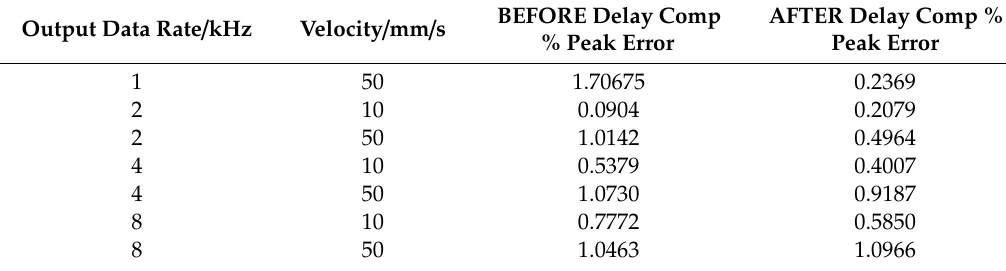
Figure 11. Percentage error plot obtained by applying interpolation on the 1 kHz 10 mm/s trajectory before delay compensation. As the group delay is a function of the output data rate (decimation rate D), the greatest delay was registered at the 1 kHz 50 mm/s case.